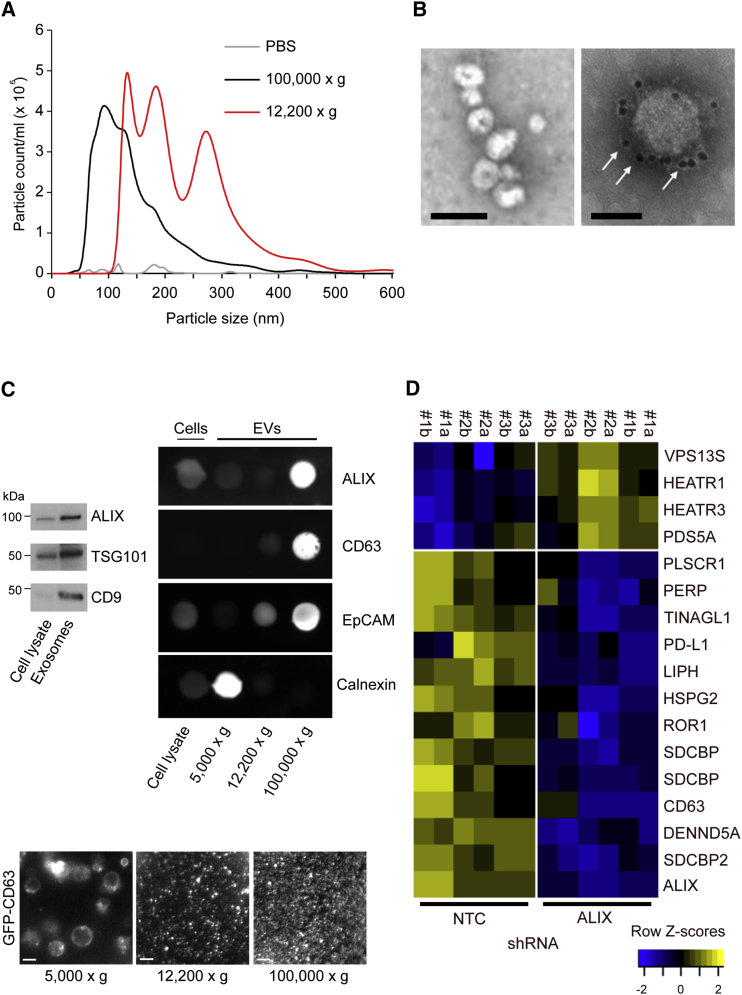
ALIX Regulates Exosomal Cargo Incorporation(A) Summary of nanoparticle tracking analysis (NTA) showing the size distribution of EVs isolated from HCC1954 culture supernatants by ultracentrifugation. Each trace is representative of individual NTA performed on five samples. Bar graph shows mean modal size of exosomal and MV fractions from n = 5 traces ± SD (∗∗∗p < 0.0001, two-tailed Student’s t test).(B) TEM of exosomes; arrows indicate CD63 immunolabeling. Scale bars, 100 nm (left image) and 50 nm (right image).(C) Western blot demonstrating the presence of exosomal markers ALIX, TSG101, and CD9 in HCC1954 cell lysates and exosomes (equal protein loaded per lane) and showing the enrichment of these three exosomal markers in the corresponding exosome lanes. Dot-blots demonstrate the relative levels of positive and negative EV markers in the lysates of cells (5 μg per spot) and EVs (1 μg per spot) harvested after the indicated centrifugation steps. Epifluorescence images of GFP-CD63-labeled EVs harvested after the indicated centrifugation steps are shown.(D) Heatmaps of changes in the exosomal proteome following ALIX KD in HCC1954 cells. Heatmaps are of protein expression across control (NTC) and ALIX KD (ALIX) samples and are displayed as row Z scores (each row is standardized by subtracting the mean value and dividing by the SD). Rows are ordered by mean fold change between NTC and ALIX sample groups (n = 3 independent experiments; proteins with mean fold change < 2 were excluded). For each treatment group (NTC or ALIX KD), the column number denotes an independent biological experiment, while the letter denotes a technical repeat. Gene name repeats indicate alternative splice variants.See also Figure S3.